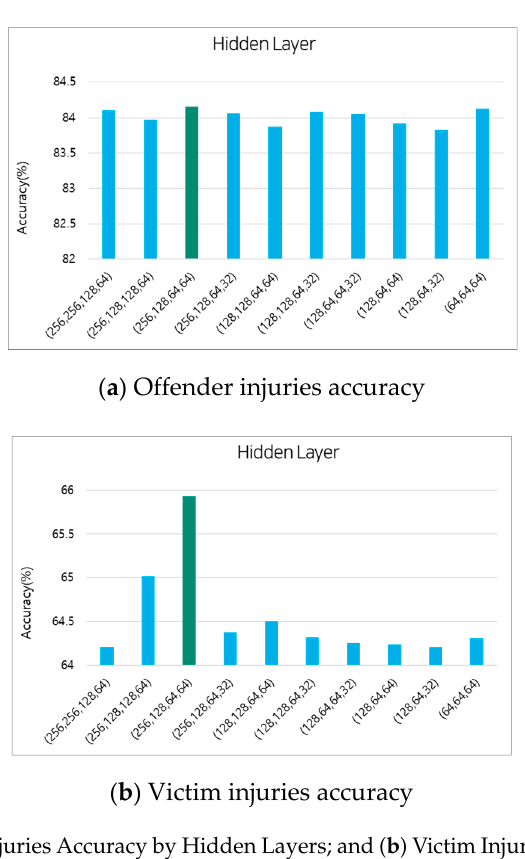
Figure 2. ( a ) Offender Injuries Accuracy by Hidden Layers; and ( b ) Victim Injuries Accuracy by Hidden Layers: Different colored bars stand for the highest accuracy is derived from the hidden layers. Table 6. Offender/Victim Injuries Accuracy by Hidden Layers. The Number of Nodes in Hidden Layer